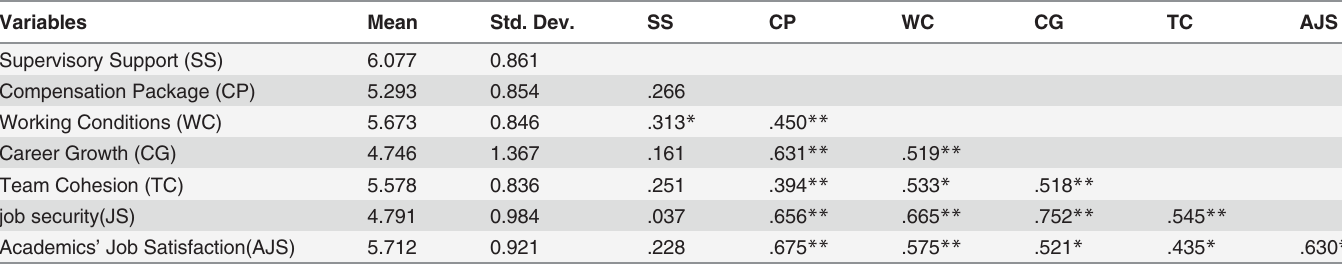
Table 2. Mean, Standard Deviation and Correlation Coef fi cient.